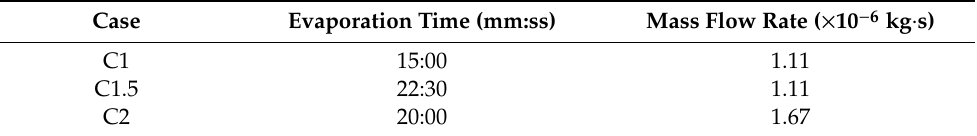
Table 4. Mass flow rate and corresponding evaporation time in simulations.